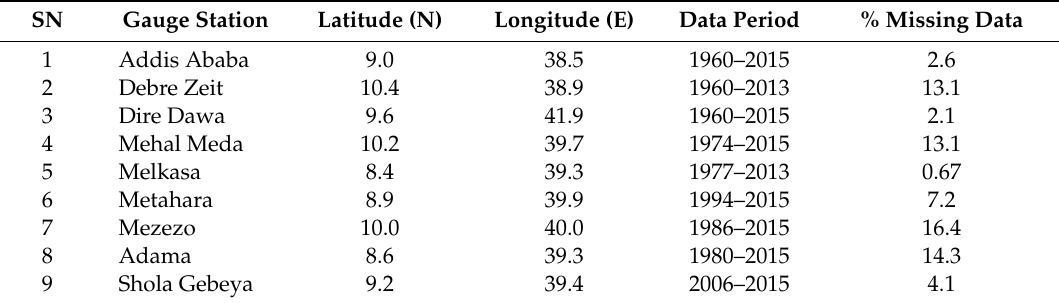
Table 1. Selected gauge stations and estimated percentage missing data.